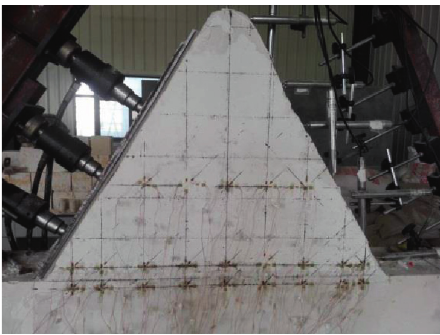
Figure 4: Loading system.